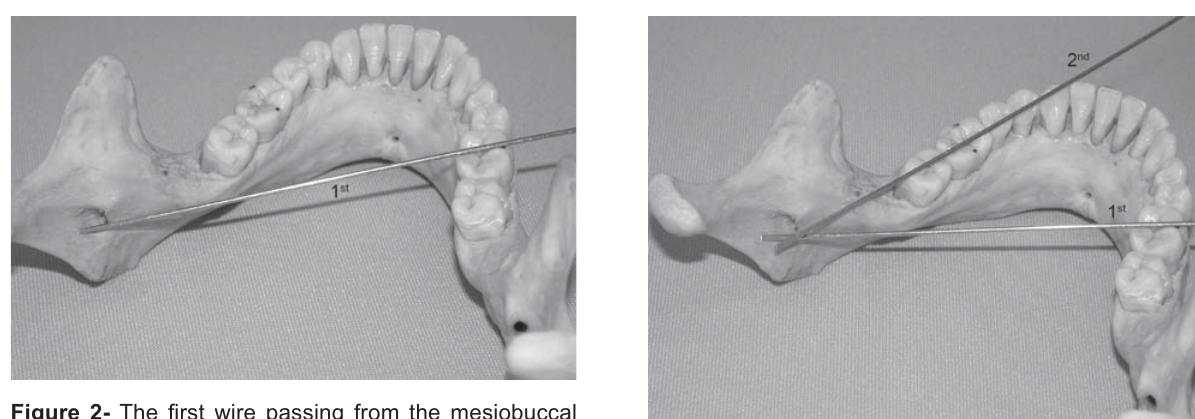
Figure 2- (cid:6)(cid:28)(cid:26)(cid:12)(cid:6)(cid:2)(cid:3)(cid:4)(cid:5)(cid:6)(cid:29)(cid:13)(cid:3)(cid:12)(cid:6)(cid:24)(cid:10)(cid:4)(cid:4)(cid:13)(cid:22)(cid:17)(cid:6)(cid:25)(cid:3)(cid:8)(cid:7)(cid:6)(cid:5)(cid:26)(cid:12)(cid:6)(cid:7)(cid:12)(cid:4)(cid:13)(cid:8)(cid:14)(cid:15)(cid:16)(cid:16)(cid:10)(cid:9)(cid:6) groove and the middle point of the slope of the distolingual cusp (or distolingual angle line) (note Figure 1) of the (cid:7)(cid:10)(cid:22)(cid:23)(cid:13)(cid:14)(cid:15)(cid:9)(cid:10)(cid:3)(cid:6)(cid:2)(cid:3)(cid:4)(cid:5)(cid:6)(cid:7)(cid:8)(cid:9)(cid:10)(cid:3)(cid:6)(cid:24)(cid:12)(cid:3)(cid:7)(cid:10)(cid:22)(cid:12)(cid:22)(cid:5) Table 1- Mean and percentage values obtained Reference tooth